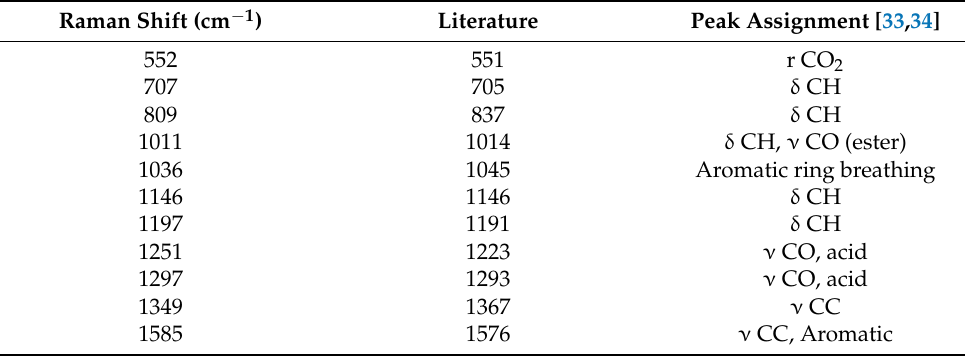
Table 1. Summary of SERS data on ASA using Au/dextran nanoparticles. Raman Shift (cm −1 )